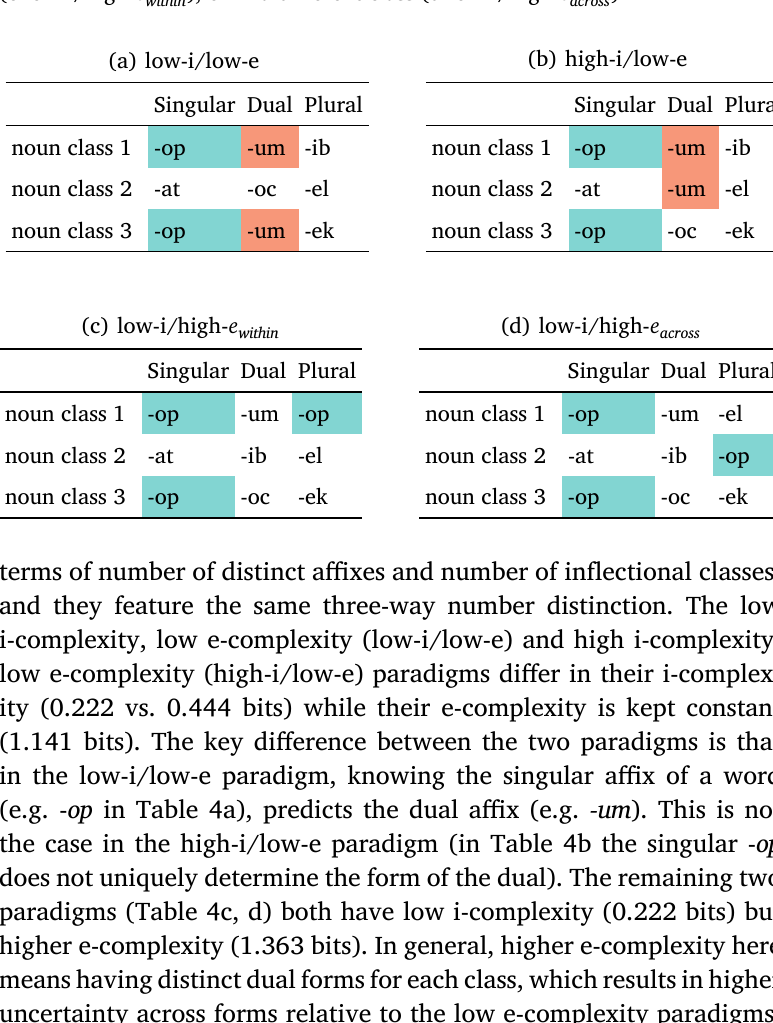
Table 4: Example paradigms for each type tested. See Table 3 for high-level descriptions of each type. Colored cells highlight distinct paradigm structures: in low-i/low-e (a), singular - op predicts dual - um ; in high-i/low-e (b), singular does not predict dual; in both low-i/high-e paradigms (c,d), the singular form which occurs most frequently is reused for plural elsewhere in the paradigm (syncretism) – either in one of the classes with that form in the singular (c low-i/high- e ), or in a different class (d low-i/high- e within across